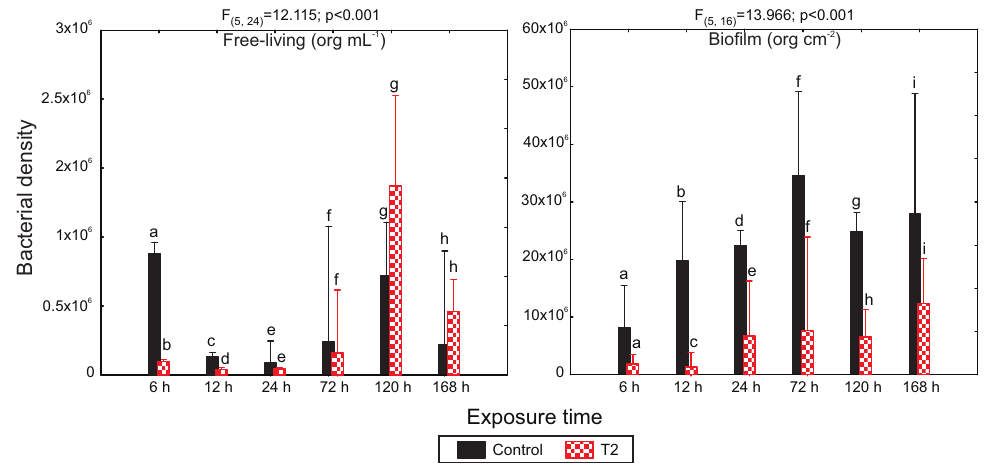
Figure 2 - Two-way aNOVa indicating average free-living (a) and biofilm (b) bacteria density exposed to control (without antibiotics) and T2 (0.025 g L -1 penicillin G potassium + 0.08 g L -1 streptomycin sulphate + 0.04 g L - 1 neomycin sulphate) over 168 hours. The bars represent the confidence intervals (95 %), and lowercase letters represent similarities or statistical differences between treatments for each time